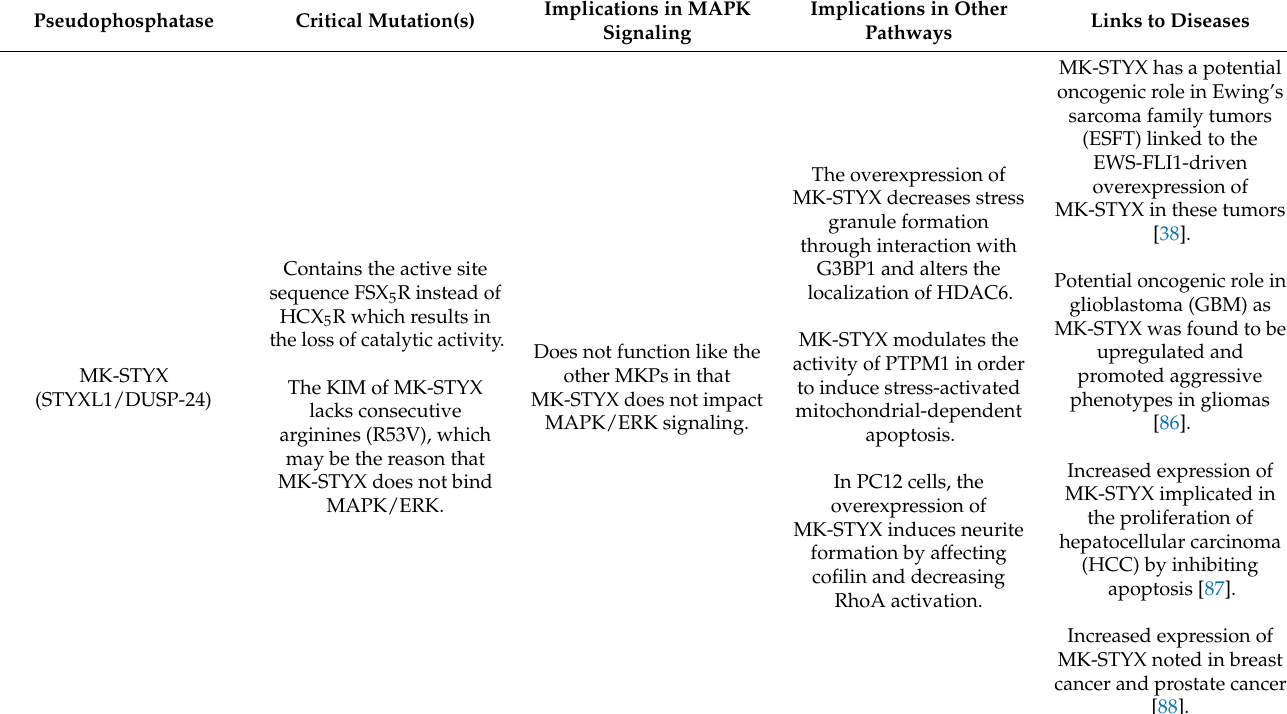
Table 1. Roles of pseudophosphatases in MAPK signaling and beyond.